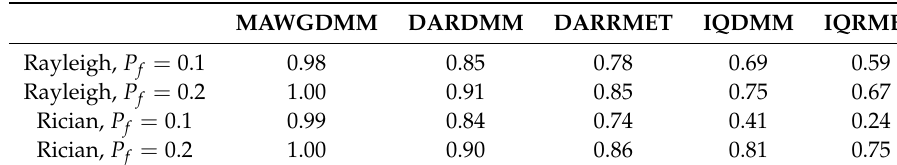
Figure 7. Comparison of the receiver operating characteristics (ROC) in different methods at SNR = − 14 dB. Table 2. Detection probabilities of different algorithms when the SNR = − 14 dB.